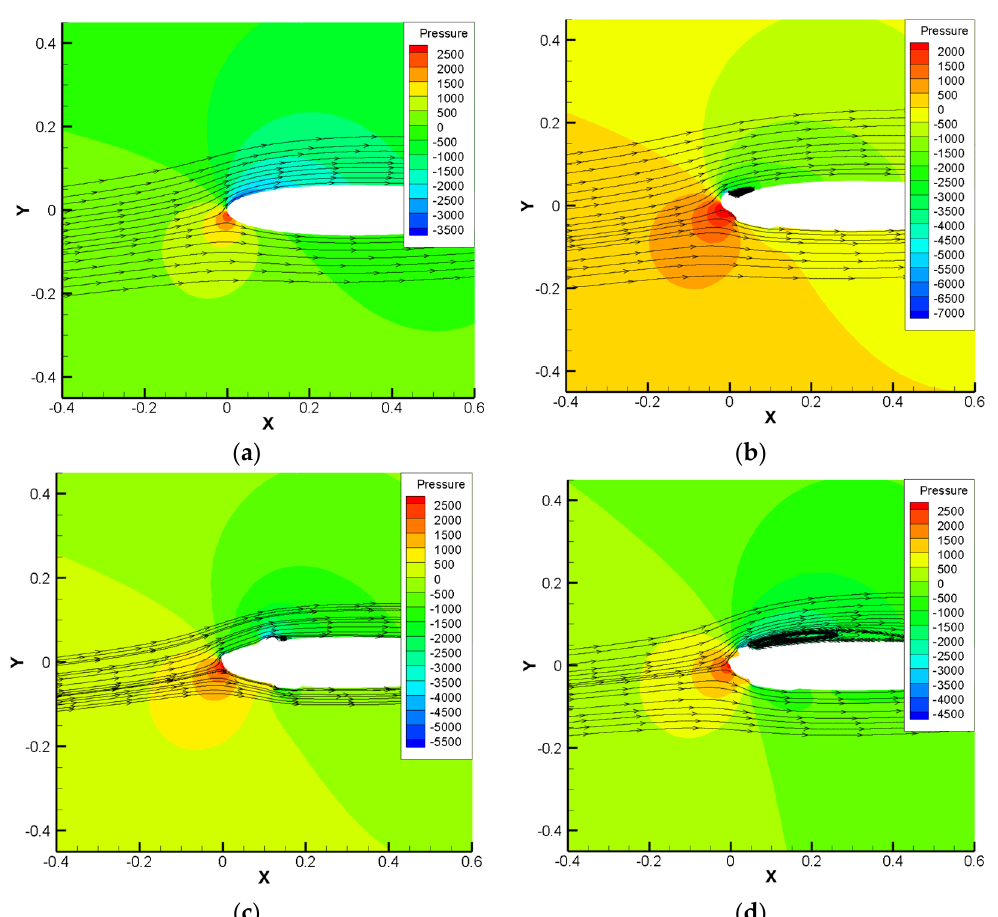
Figure 9. Aerodynamic characteristics of airfoil after icing: ( a ) Cl; ( b ) Cd.